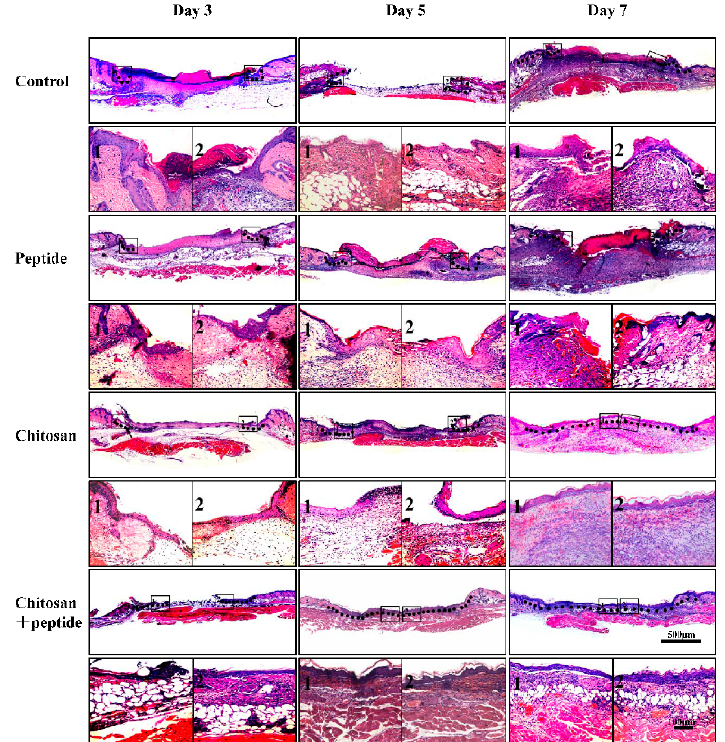
Figure 2. HE staining showed that the wounds were re-epithelialized on days 3, 5 or 7 after trauma in mice in the control, SIKVAV, chitosan, and SIKVAV-modified chitosan groups (scale bar: 50 µ m). (The black frame indicates the junction between the re-epithelialization and non-re-epithelialization in the skin wound. The meaning of 1 and 2 means that the above corresponding picture is enlarged. 1 represents a magnified picture of the black frame on the left, and 2 represents a magnified picture of the black frame on the right.).